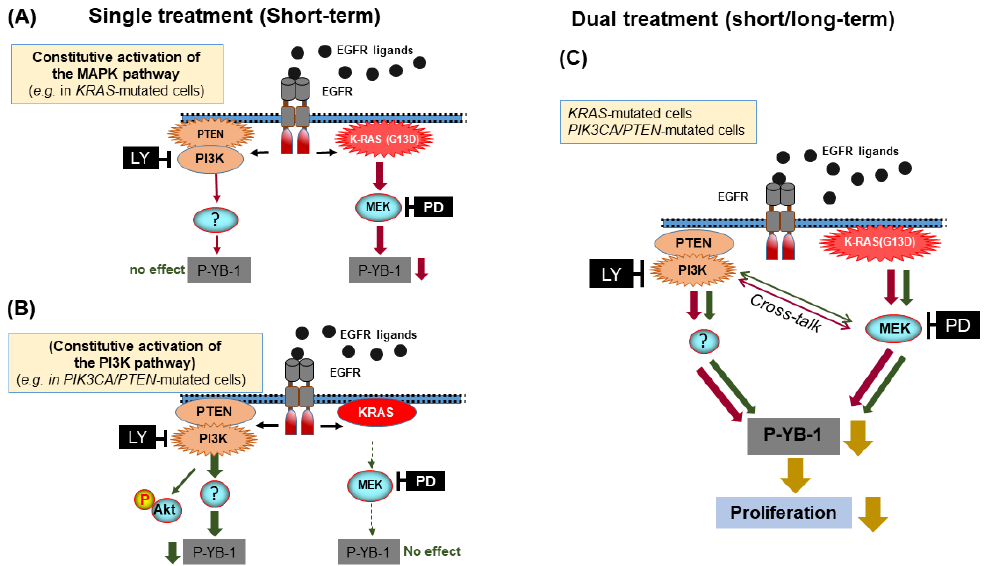
Figure 5. Model demonstrating dual targeting of PI3K and MEK as an efficient approach to target constitutive activation of YB-1 in KRAS (G13D)-mutated and PIK3CA / PTEN -mutated TNBC cells. A short-term (2 h) inhibition of constitutive PI3K or ( A ) MEK activity ( B ) efficiently inhibits YB-1 phosphorylation at S102, while long-term inhibition of each pathway leads to YB-1 reactivation by the alternative pathway ( C ). Dual targeting of both pathways blocks the crosstalk-mediated reactivation of YB-1, leading to the efficient blockage of cell proliferation.